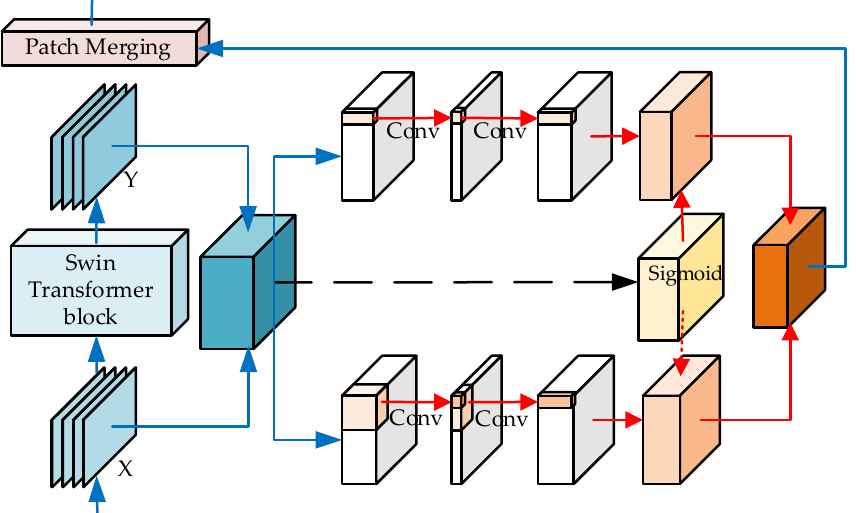
Figure 3. Feature enhancement module, which uses CNN to enhance the relationship between channels and improve the expression ability of the model.